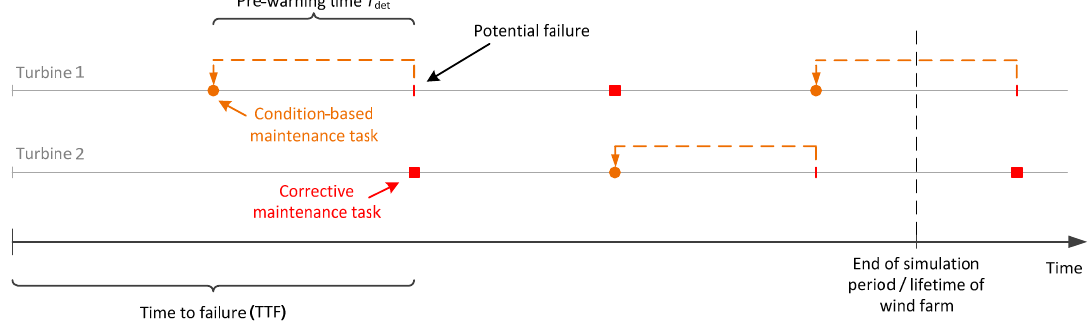
Figure 9. Illustration of the effect of pre-warning time on the time of CBM tasks.